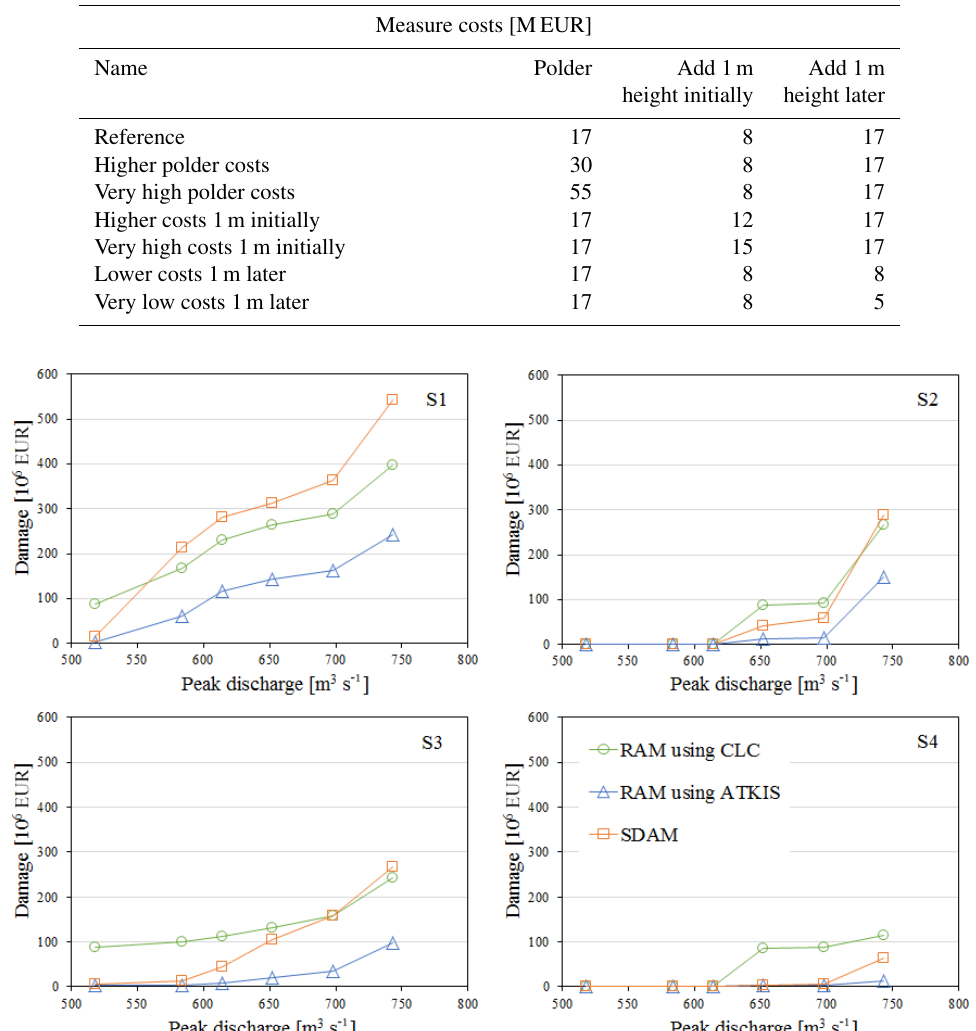
Table 7. Cost estimates used for optimization. In order to study sensitivity, polder costs, the costs of increasing dikes and walls initially and the costs of increasing dikes and walls later were varied.